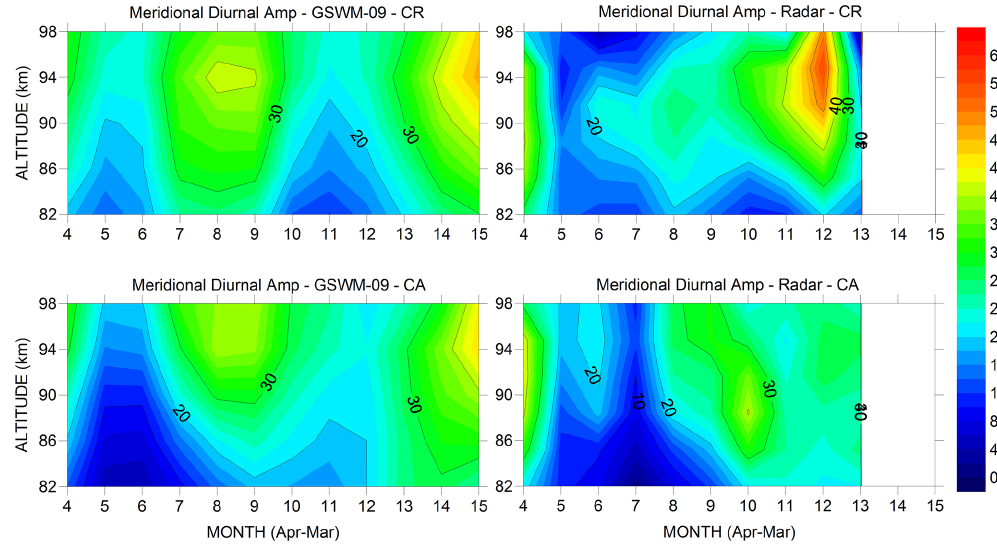
Figure 3. Same as Fig. 2 but for meridional amplitude. The color scale here is double the scale in Fig. 2.